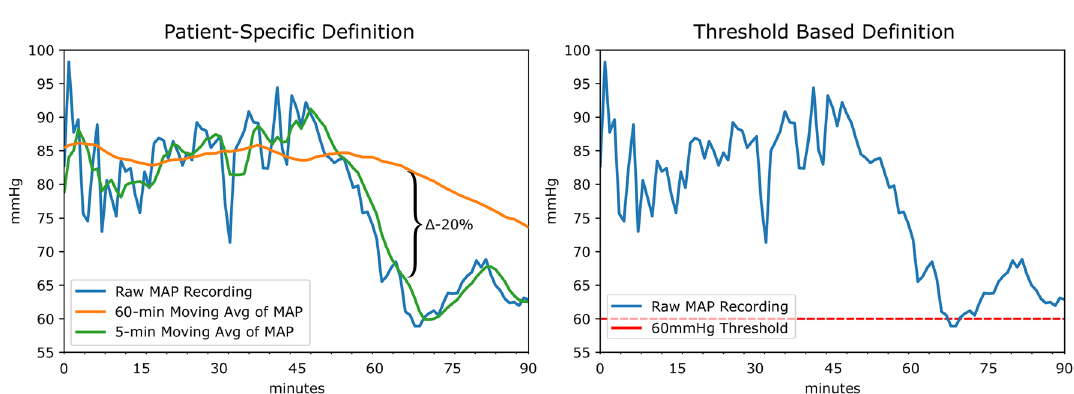
Figure 1. Experimental workflow and study design. Data from both the KGH and MIMIC-III databases are annotated and processed before being partitioned into three sets that are used for training, validation, and testing. Initial model development is performed using data from KGH exclusively. The models are then adapted via transfer learning using MIMIC-III data. All models are evaluated using held-out internal and external test sets.